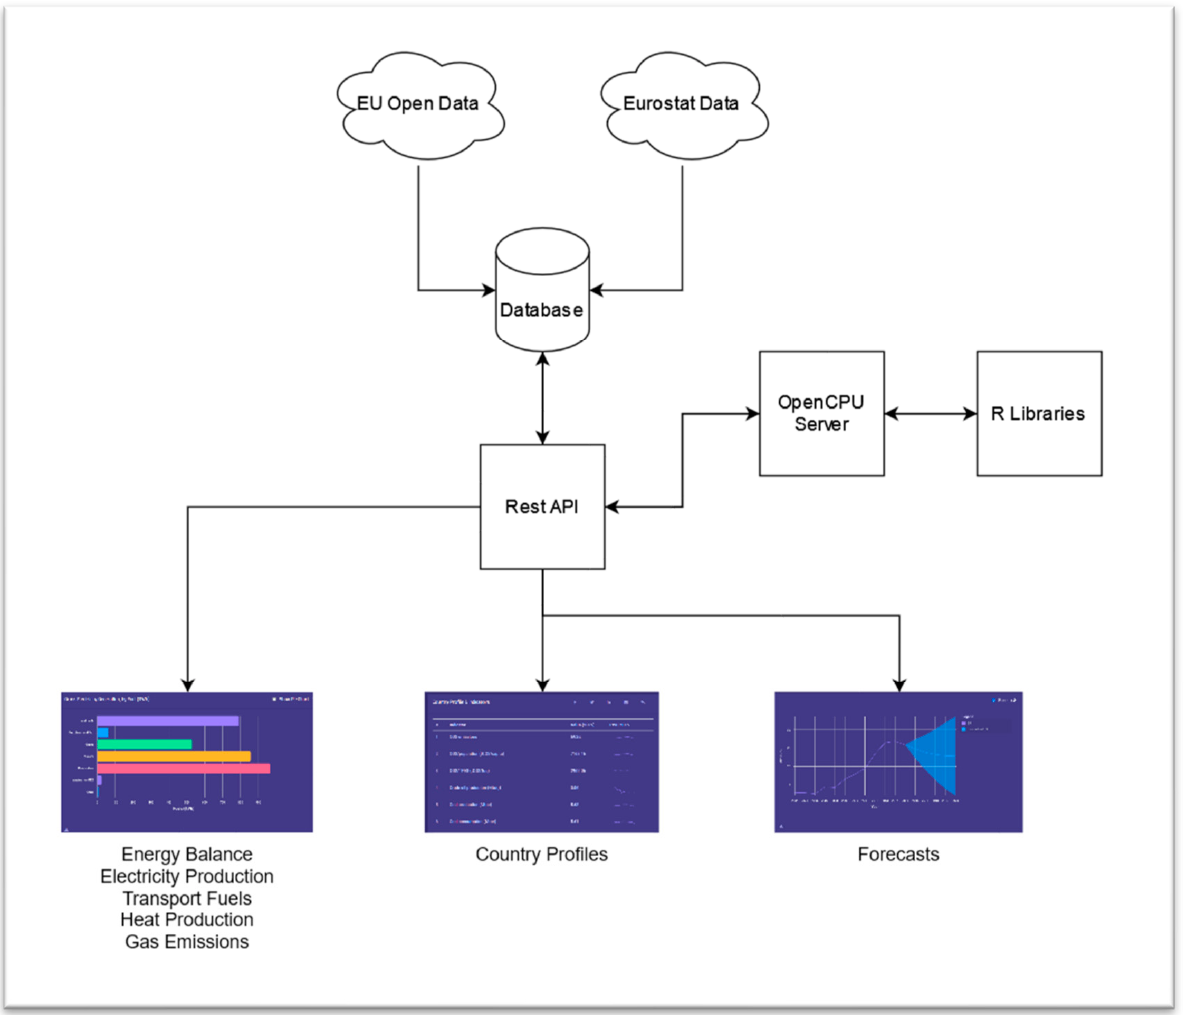
Figure 1. Basic structure and components of the OpEnergy tool and related architecture.